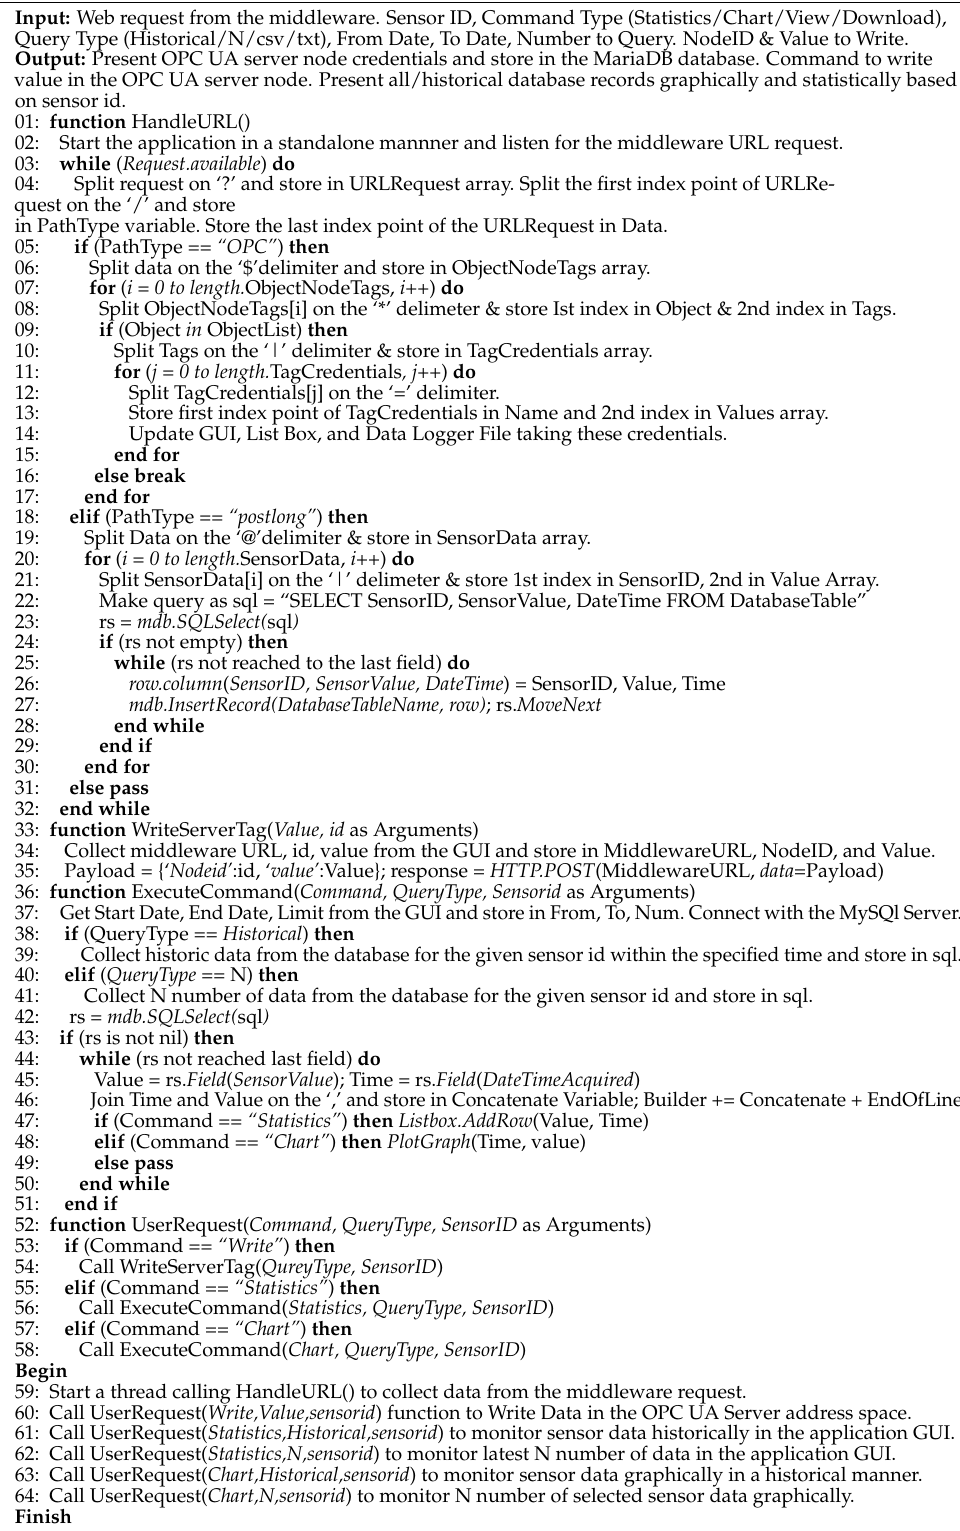
Algorithm 3. REST-Aware-Based Web Service and ThingsSentral TM Cloud Platform Development